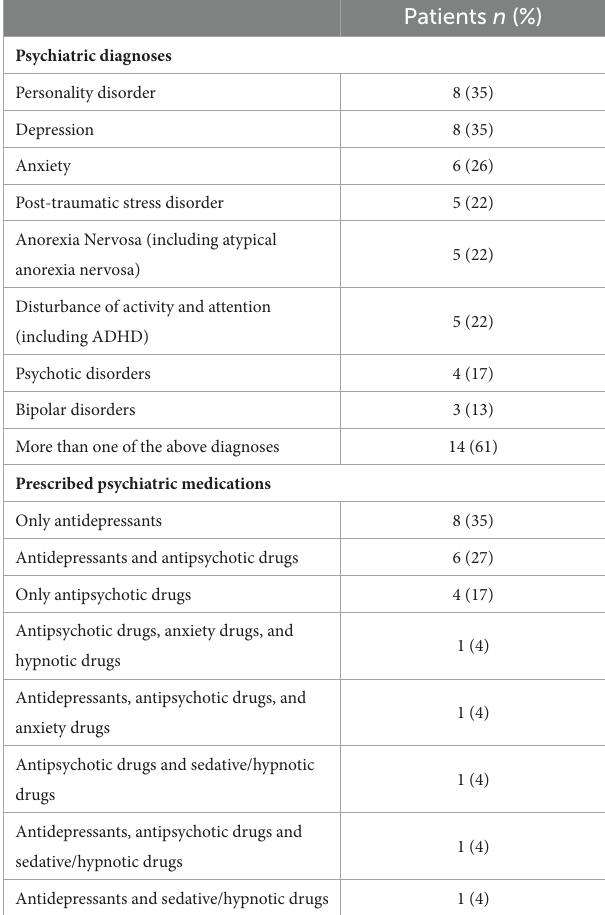
TABLE 2 Frequency of the most common psychiatric diagnoses and prescribed psychiatric medications for the patients, values shown as number of patients (percent).